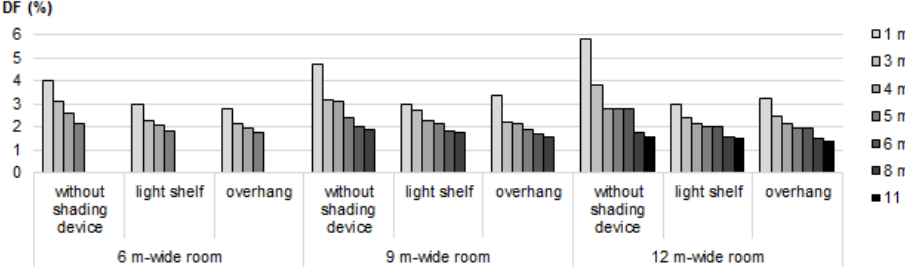
Fig. 4. DF at certain distance (m) from the windows inside 6 m, 9 m and 12 m wide rooms on the first floor in an urban area with h / w = 4 and le / L = 0.25.